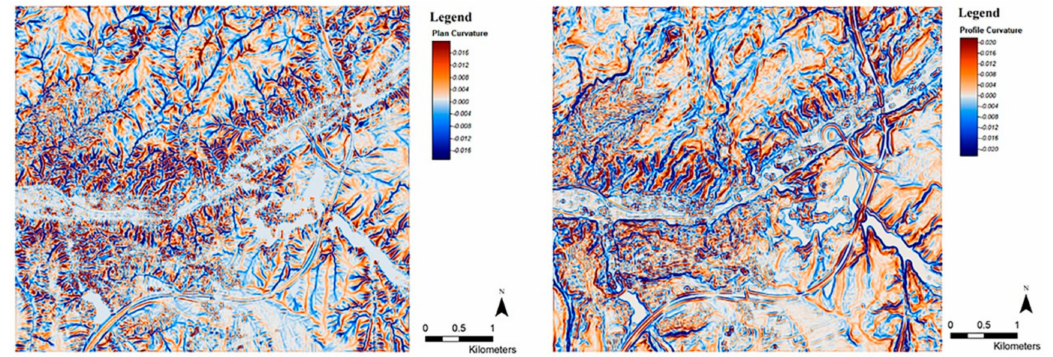
Figure 6. Plan ( left ) and profile ( right ) curvature maps of the study area.